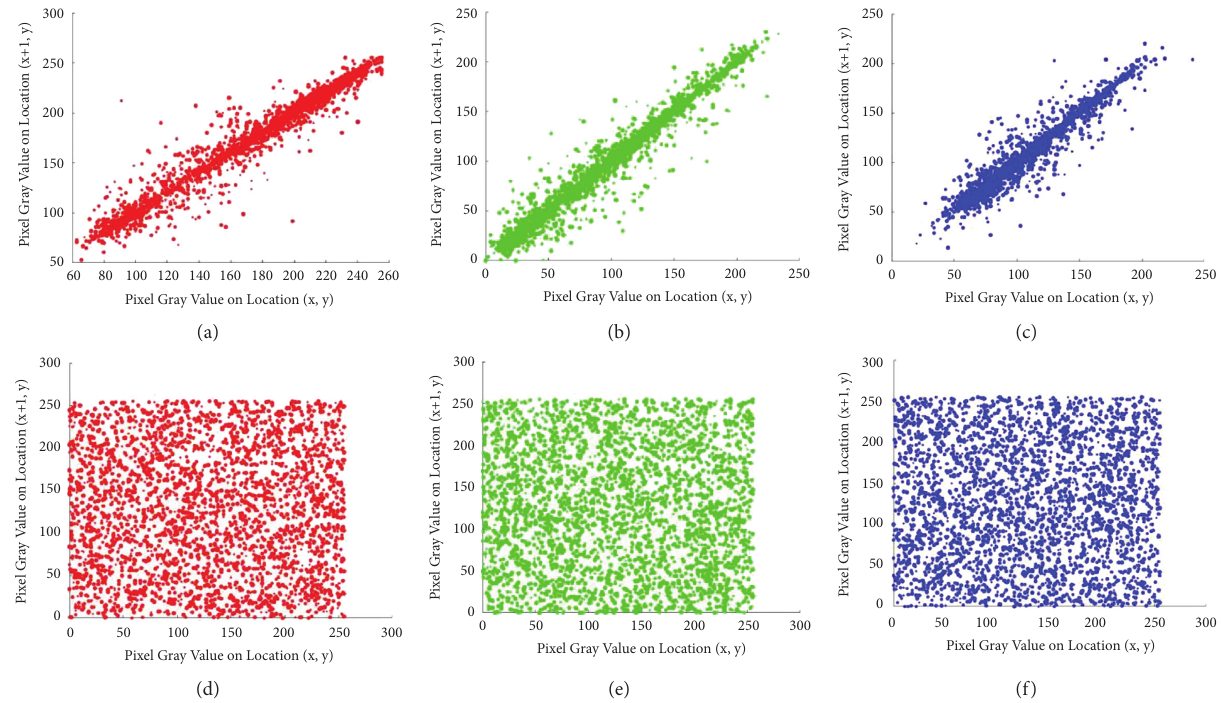
Figure 12: Correlation distribution of color “Lena” image: (a)–(c) show RGB layers of plain image; (d)–(f) show RGB layers of cipher image for vertical, horizontal, and diagonal directions,